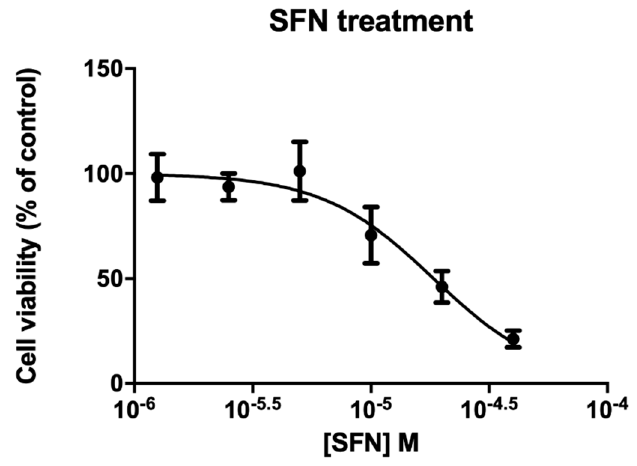
Figure 1. Cytotoxicity effects of sulforaphane (SFN) on IHH cell line. Cells were exposed for 72 h to SFN and cytotoxicity effects were analyzed by MTT assay. Data are reported as means ± SE of 3 independent experiments performed in triplicate. O.D.% observed to untreated cells.